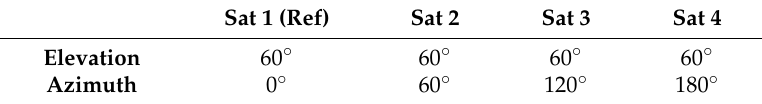
Figure 4. An example for multiple intersection points. Table 2. Satellite geometry distribution for Figure 4.